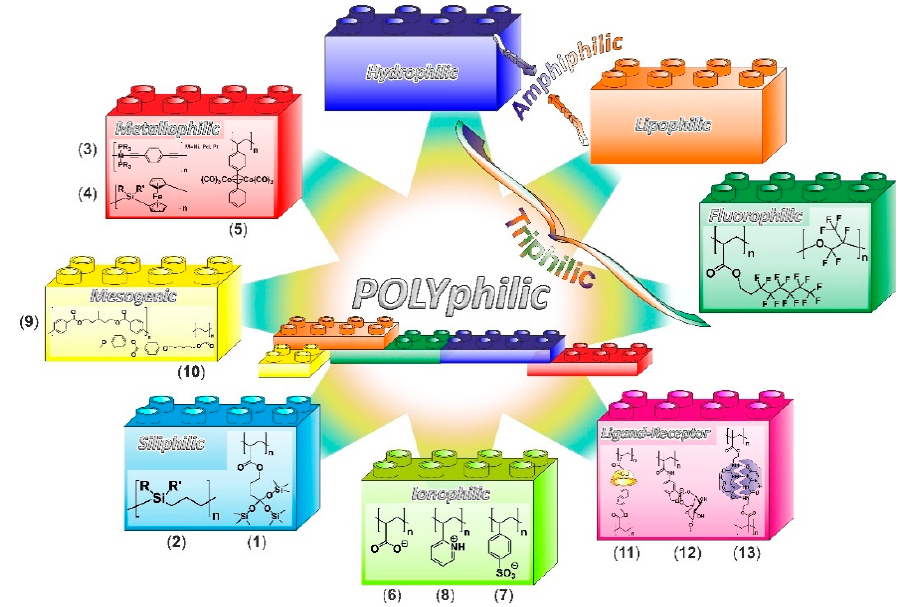
Figure 4. Representative structure motifs present in polyphilic polymers. (1,2)—Siliphilic; (3–5)—metallophilic; (6–8)—ionophilic; (9,10)—mesogenic; (11–13)—ligand-receptor.